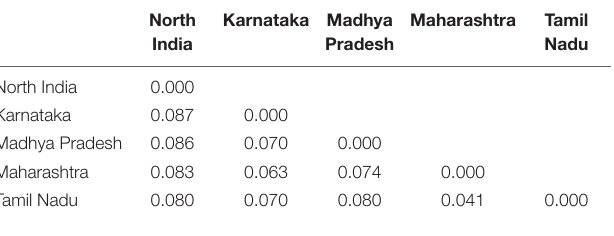
TABLE 4 | Pairwise population matrix of Nei’s genetic